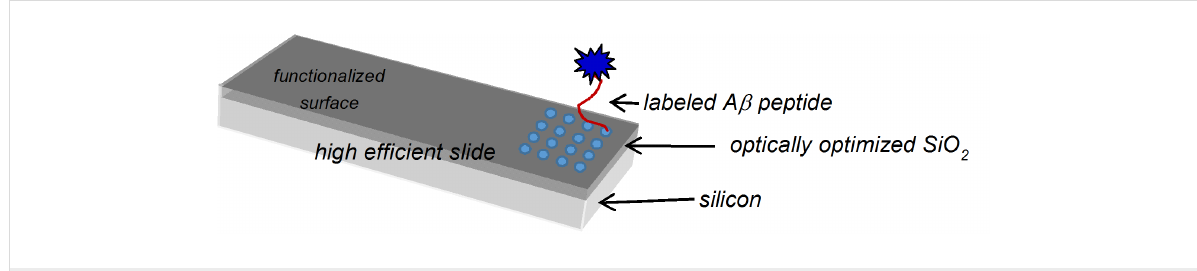
Figure 5: HES with a sketch of incubation test site. The peptide array is represented by blue dots.